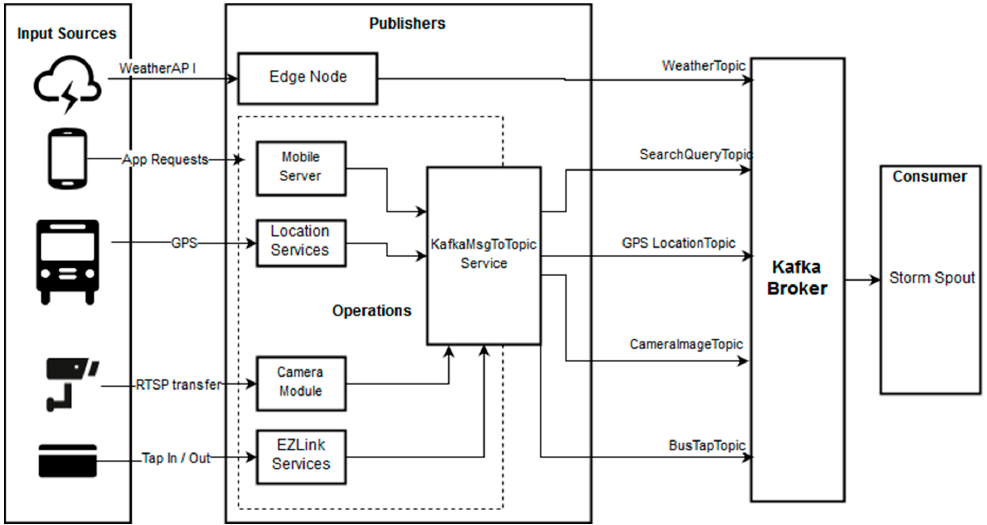
Figure 2. Data flow model of MOBDA from various big data input sources.